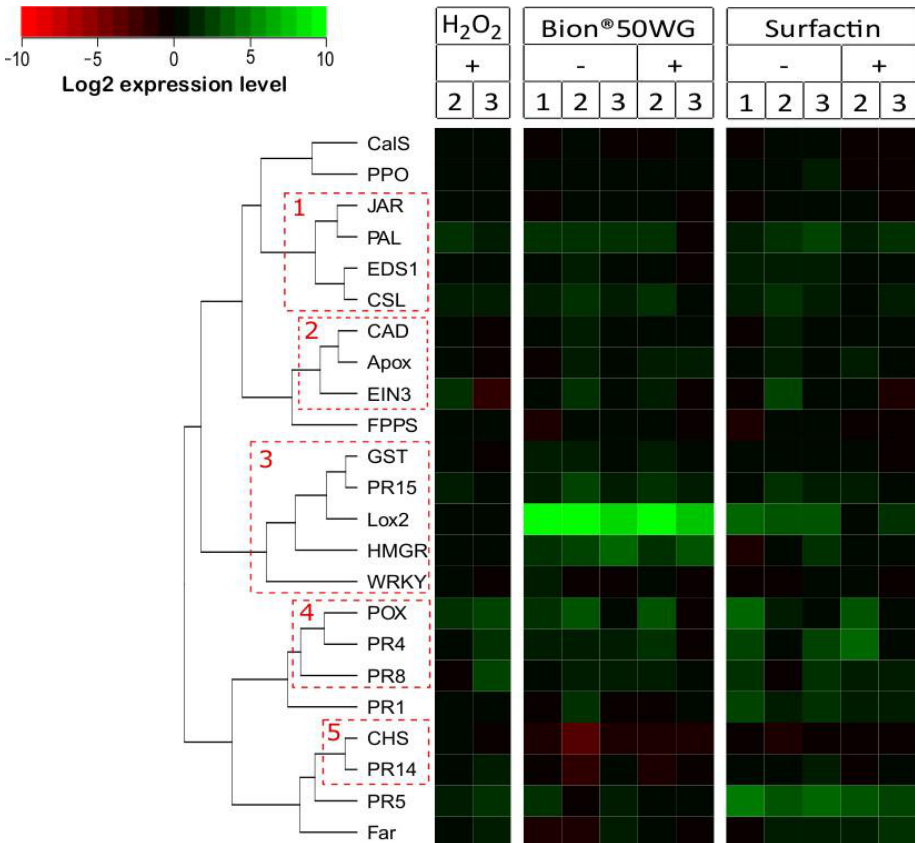
Figure 4. Heatmap profiling across all experimental conditions (product, ±H 2 O 2 , day post-treatment) with hierarchical clustering of 23 defense-related genes of wheat [23]: Apox , ascorbate peroxidase; CalS , callose synthase; CHS , chalcone synthase; CAD , cinnamyl-alcohol dehydrogenase; CSL , cysteine sulfoxide; EIN3 , EIN3-binding F box protein; EDS1 , enhanced disease susceptibility 1; Far , ( E , E )- α -farnesene synthase; FPPS , farnesyl pyrophosphate synthase; GST , glutathione S -transferase; HMGR , hydroxymethyl glutarate-CoA reductase; JAR , jasmonate resistant 1; Lox2 , 13-lipoxygenase 2; PAL , phenylalanine ammonia-lyase; PR , pathogenesis-related protein; PPO , polyphenol oxidase; POX , peroxidase; WRKY , WRKY transcription factor 30. The averaged defense gene expression profiles are compared to a water control, and were obtained after plant treatment at the 3–4 leaf stage. Treatments consisted of water control plants subsequently treated with hydrogen peroxide after 1 day (H 2 O 2 ), the elicitor reference BION ® applied at 0.6 mg mL −1 , or surfactin applied at 0.01 mg mL −1 .